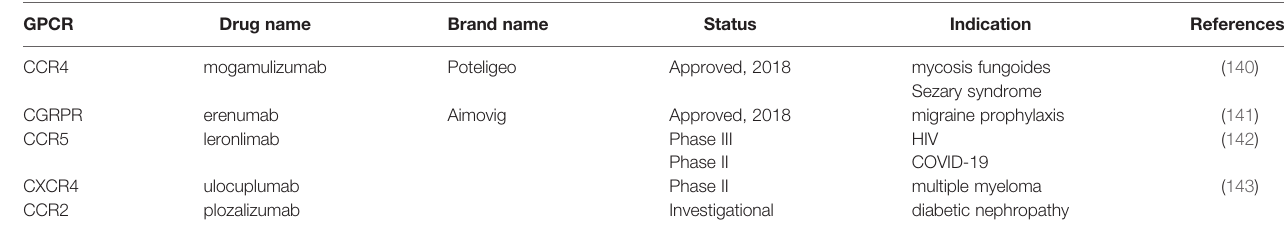
TABLE 3 | Status of GPCR therapeutic